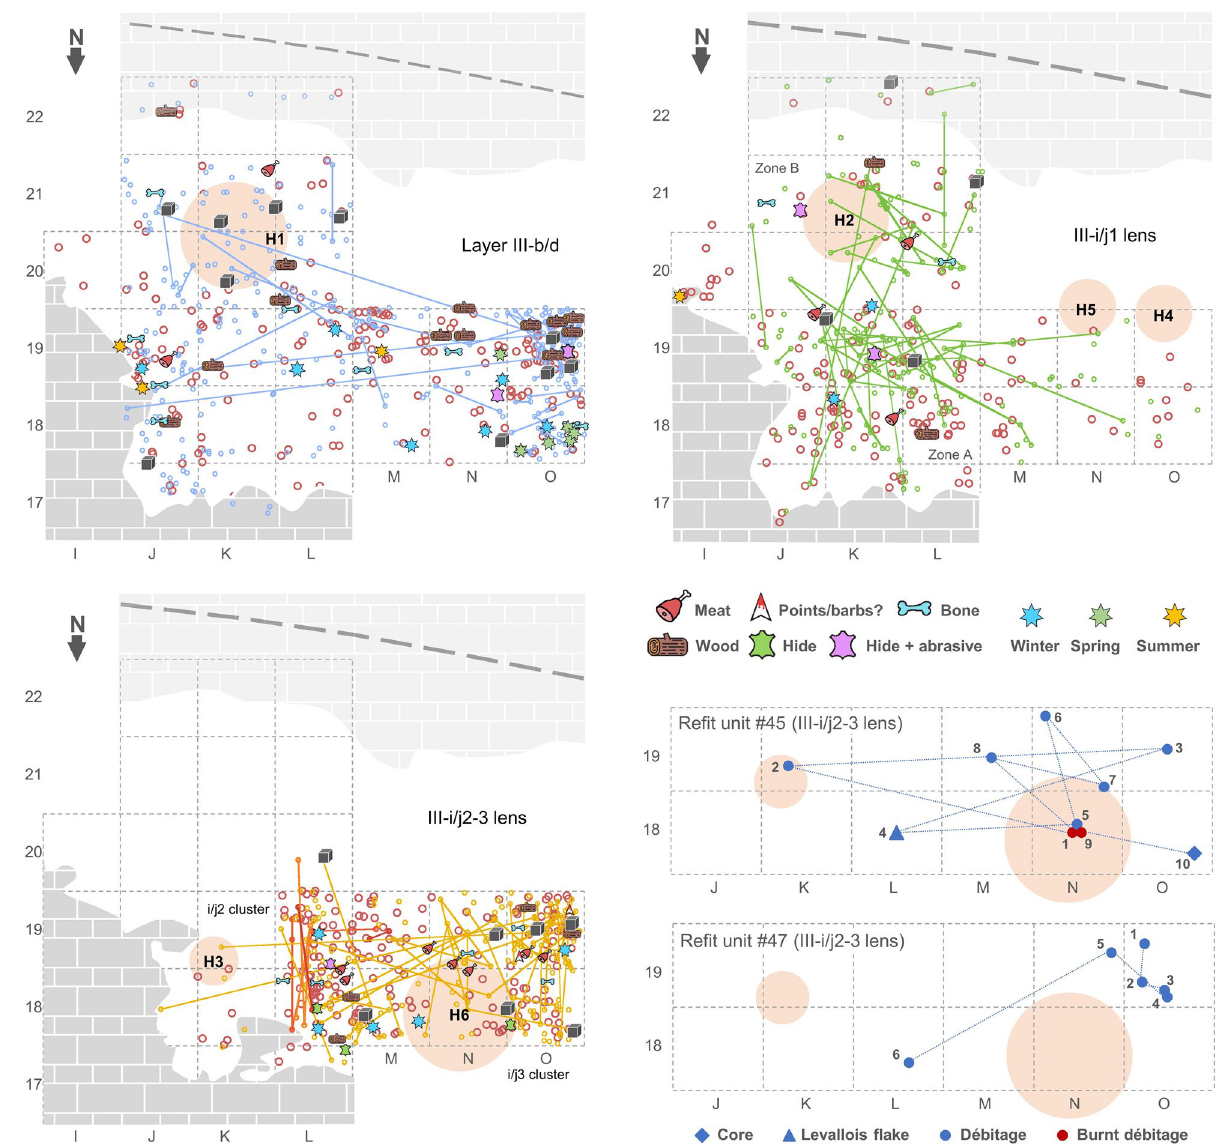
Figure 8. Spatial organization. Schematic plans of the living floors illustrating the distribution of faunal remains (tawny circles) and stone tools in relation to the hearths. Refitting connections are indicated, the grey cubes denote cores on block, and the markers denote the positions of the lithics that bear diagnostic use-wear or of the faunal remains that yield seasonality information. The outline of the bedrock shelf bounding the infill to the North is given as observed at the elevation of the layers’ surface. The outline of the back wall is given as observed at the top of the sedimentary infill, prior to excavation, and, approximately (as inferred from the concave configuration displayed in the J > I, L > M, and N > M stratigraphic profiles), at the layers’ surface (the long-dash line). The horizontal distribution of the items in Refits #45 (two way) and #47 (one way) are shown separately to illustrate the connection between the III-i/j2 and III-i/j3 clusters of the III-i/j2-3 occupation